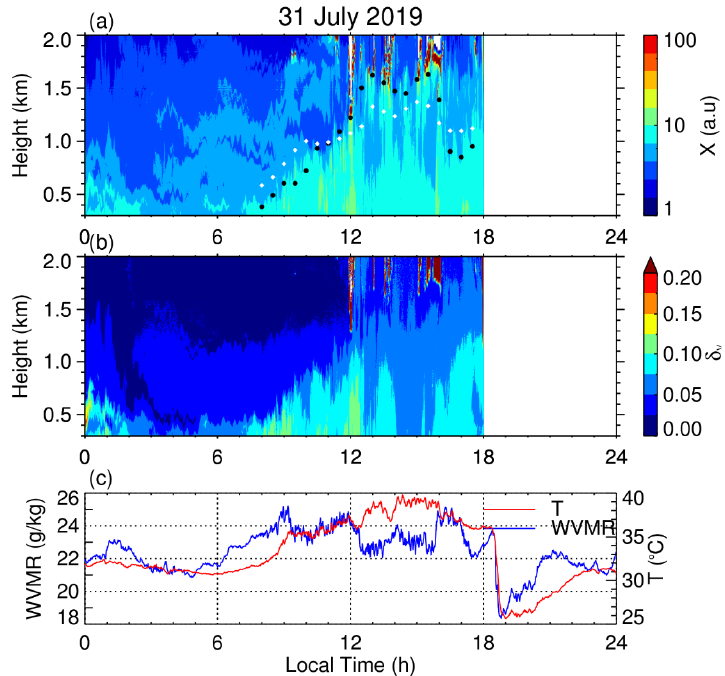
Figure 4. Time–height contour plots (1 min/3.75 m resolution) of ( a ) range-squared-corrected signal X; ( b ) volume depolarization ratio δ V measured by Wuhan University 532 nm polarization lidar on the 31st of July, 2019; and ( c ) diurnal variation of the surface temperature (T) and WVMR, recorded by a co-located surface weather station. Note that shallow cumuli rapidly formed and vanished at the top edge of the convective boundary layer between 12:00 and 16:30 LT when both the near-surface air temperature and water vapor mixing ratio were high.